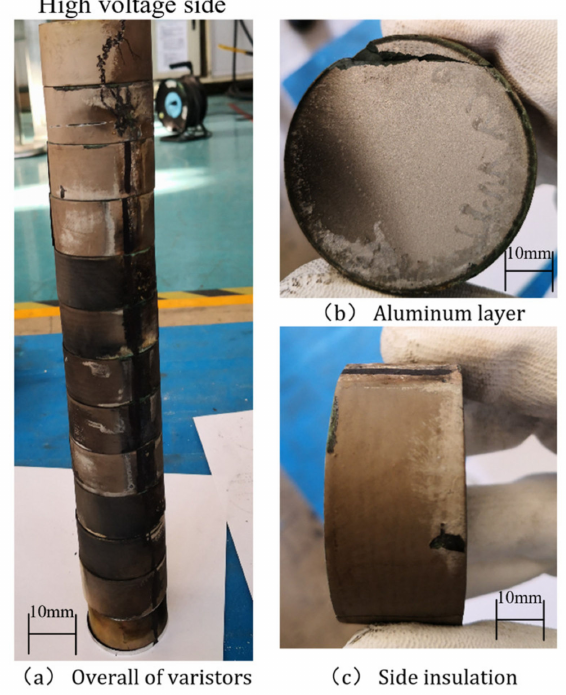
Figure 6. Typical appearance of a defective arrester